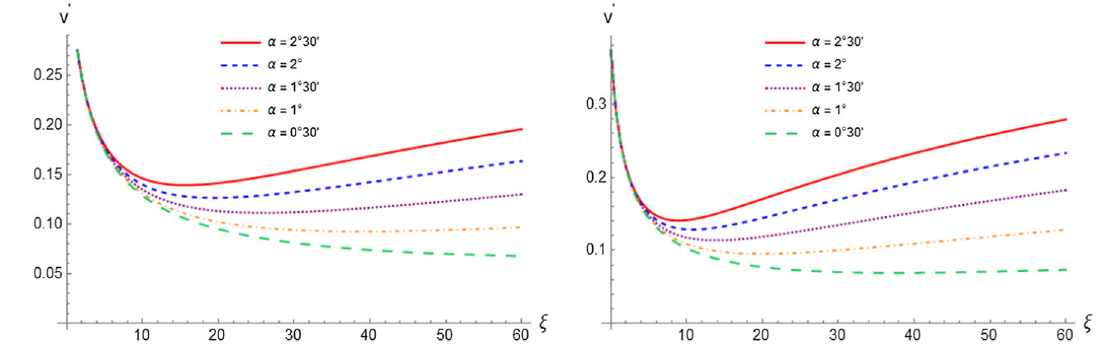
Fig. 8 Plots of the absolute value of downstream velocity | v (cid:2) (ξ | α) | as a function of the anisotropy parameter ξ for small incidence angles α = 2 ◦ 30 (cid:2)